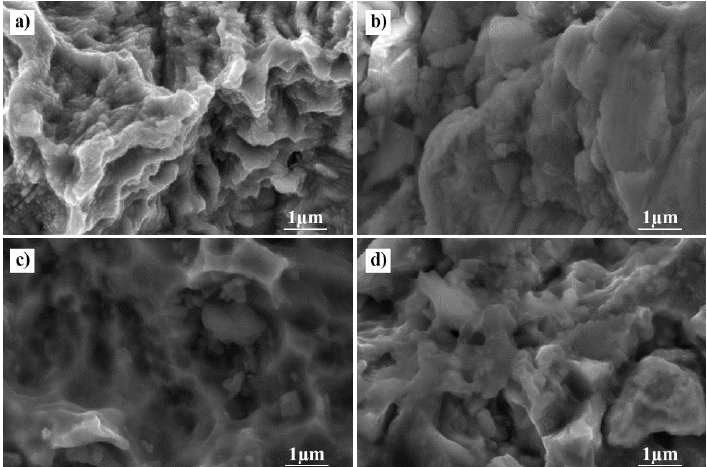
Figure 12. SEM micrograph (10,000 × magnification) showing implant morphology for ( a ) Samples 1, ( b ) 2, ( c ) 3, and ( d ) 4.